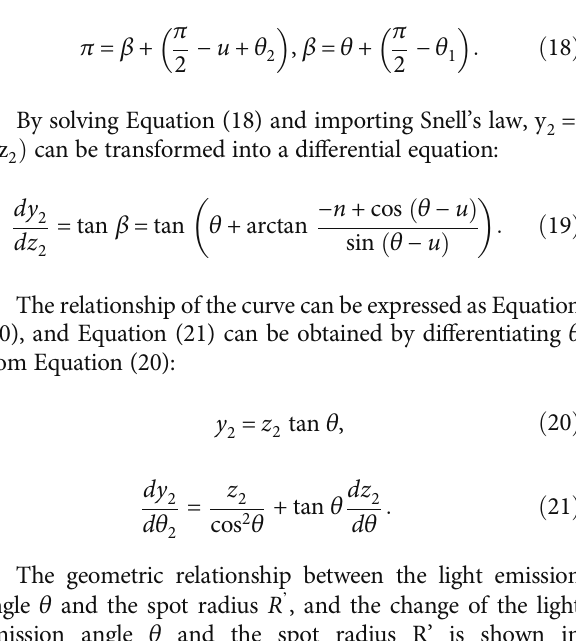
Figure 9: The lighting performance display of the secondary recognition visual communication image